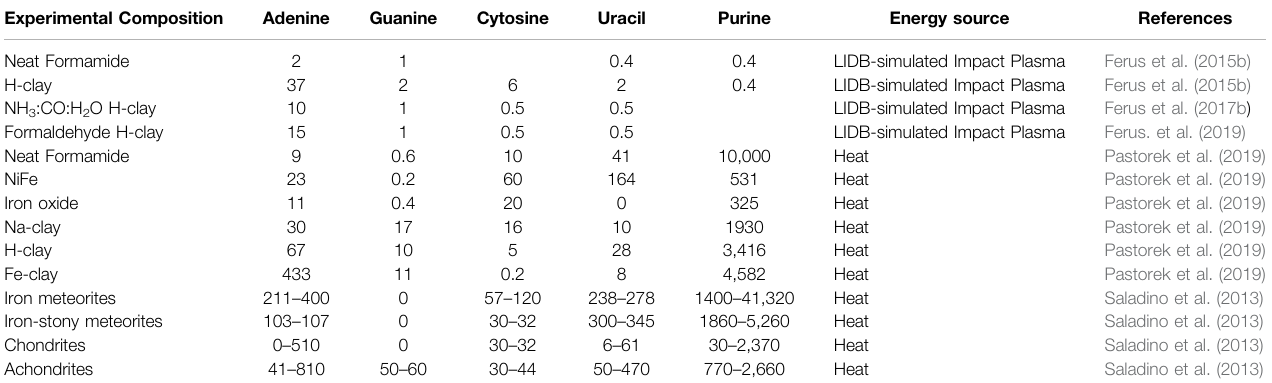
TABLE1| Comparisonoftheresultsonformamide-basedthermalprebioticsynthesisinthepresenceofmeteorites(Saladinoetal.,2013)andtestingofthecatalyticeffectof clays (Pastorek et al., 2019), and formation from formamide (Ferus et al., 2017b; 2015b) and formaldehyde (Ferus et al., 2019) in impact-plasma simulations. Units are in